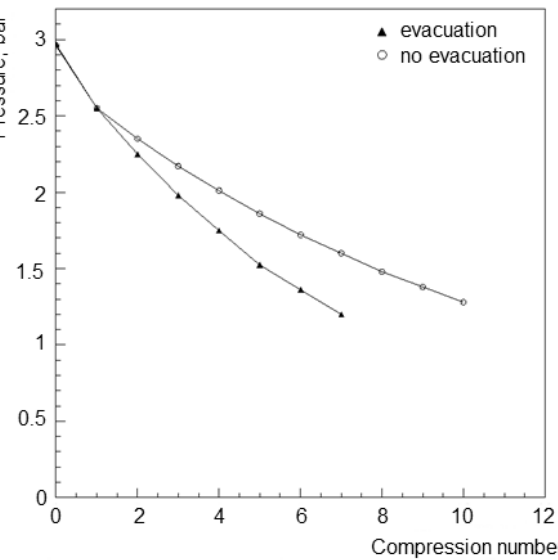
Figure 7. Decrease of the input pressure after each compression for two possible options. Step 0 corresponds to the initial pressure of 3 bar in the glass ball.